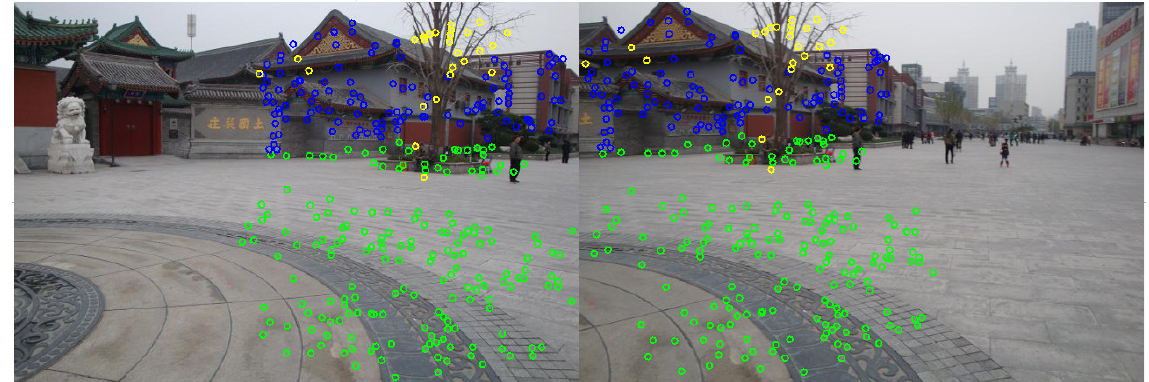
Figure 1. The optimal similarity transform estimation